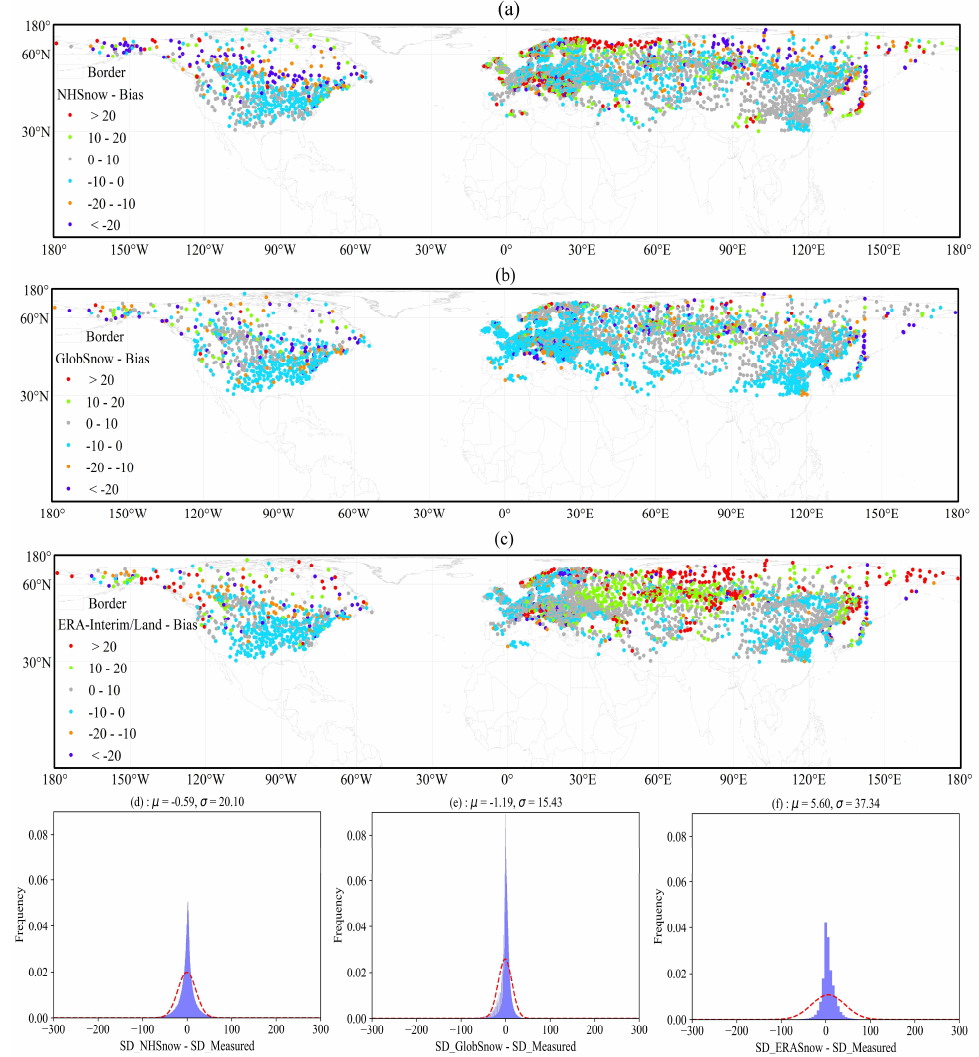
Figure 3. Bias of each meteorological station and histogram of biases for three snow cover datasets: ( a , d ) NHSnow; ( b , e ) GlobSnow, ( c , f ) ERA-Interim/Land. Site bias is calculated based on all of the valid records in each station during 1992–2010 (December to February). The red dashed line in the bottom row of figures are the fitted normal distribution curve. μ and σ in ( d – f ) indicate the mean value and standard deviation of the difference between the estimated snow depth (SD) and measured SD, respectively.